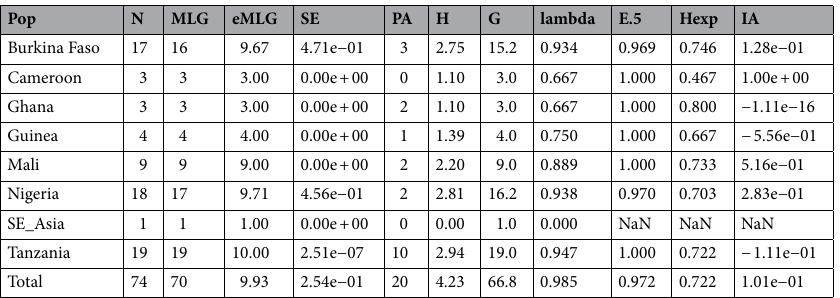
Table 5. Summary statistics of microsatellite loci showing genotypic richness, diversity, and evenness by population. N number of individuals observed, MLG number of multilocus genotypes (MLG) observed, eMLG number of expected MLG at the smallest sample size ≥ 10 based on rarefaction, SE standard error based on eMLG, PA number of private alleles, H Shannon–Wiener Index of MLG diversity, G Stoddart and Taylor’s